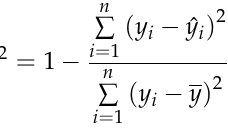
Table 3. Weight coefficient of the optimal features.